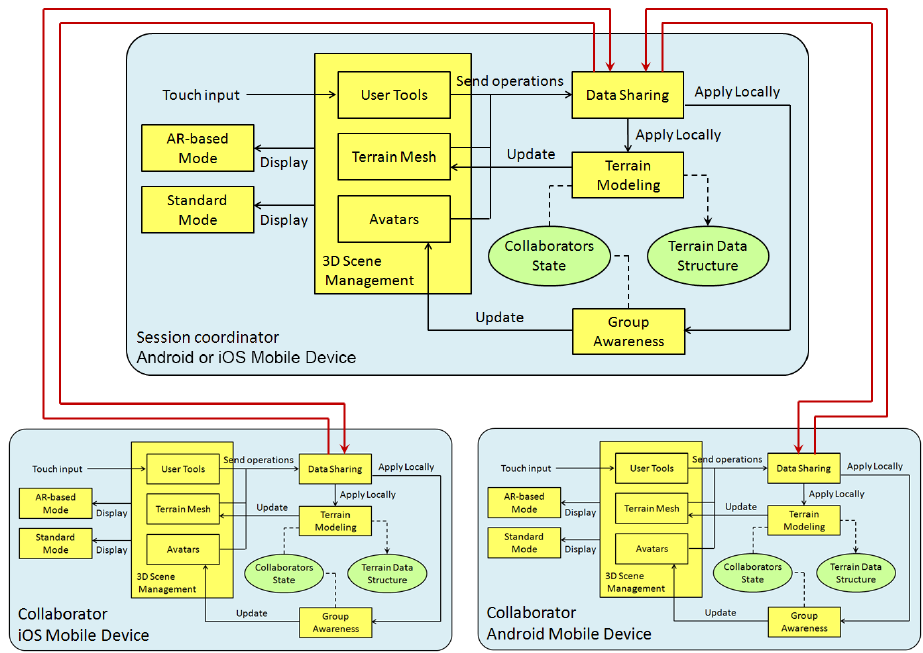
Figure 8. Distribution and communication schemes for the ShAREdT-based collaborative applications for terrain